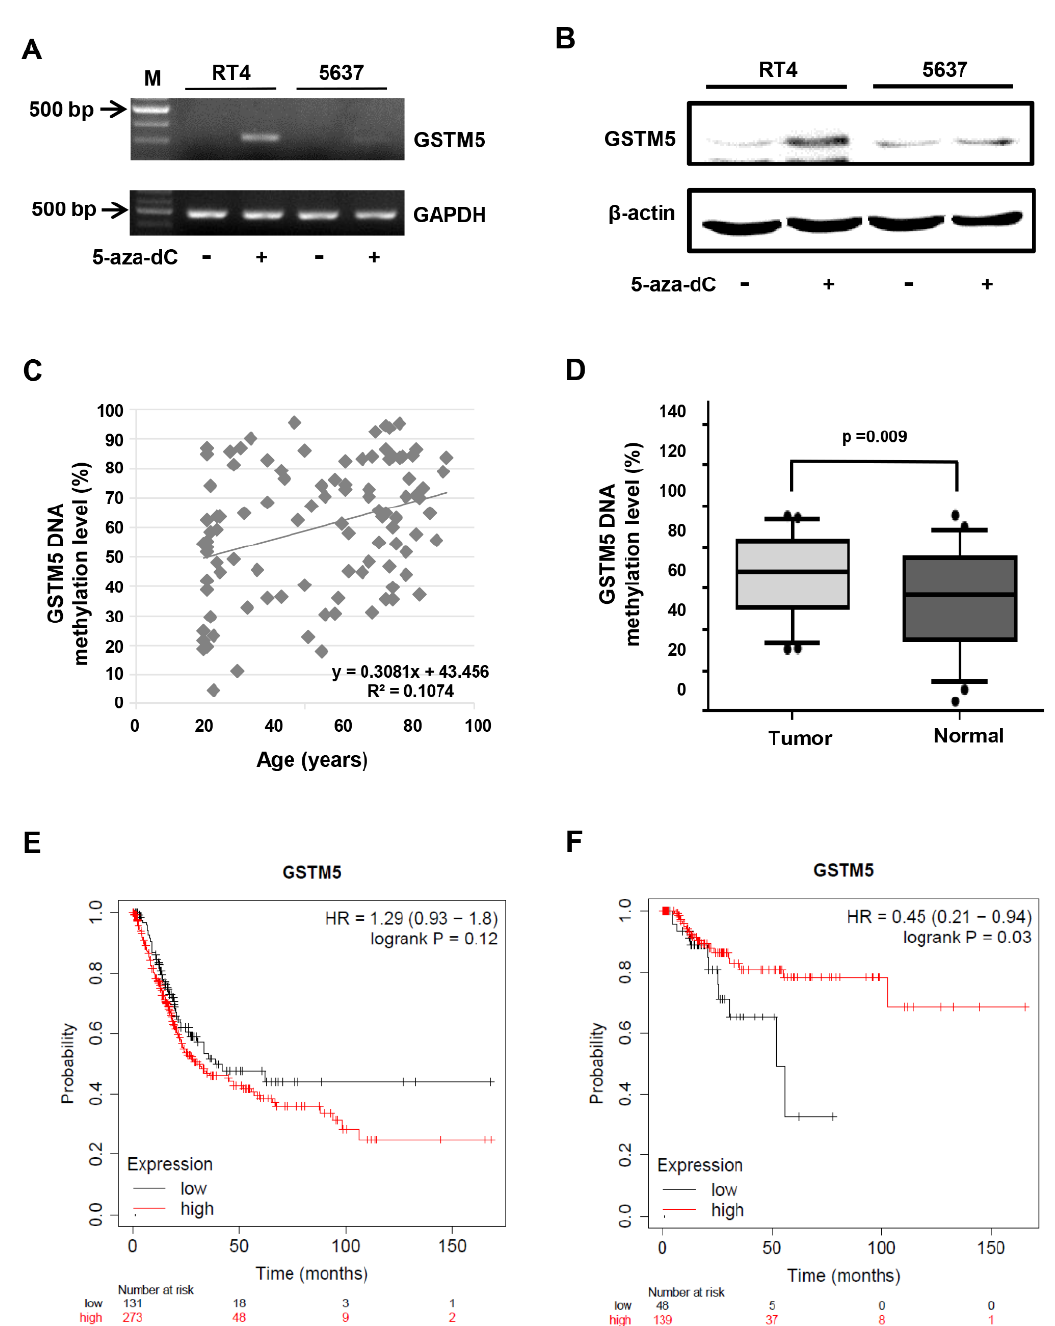
Figure 2. The status of GSTM5 DNA methylation in bladder cancer cells and clinical samples. ( A ) The effect of 10 µ M 5-aza-dC on GSTM5 mRNA expression. ( B ) The effect of 10 µ M 5-aza-dC on GSTM5 protein expression. The anti-GSTM5 antibodies were Abnova H00002949-D01P. ( C ) Correlation between age and GSTM5 DNA methylation level in 50 bladder cancer tissues and 50 normal human urine pellets. The linear regression formula is on the bottom right (R 2 = 0.1074), which was calculated by Microsoft Excel. ( D ) GSTM5 DNA methylation level in 50 bladder cancer tissues and 50 normal human urine pellets. The statistical results were analyzed by SigmaPlot. ( E ) Kaplan–Meier plot showing the overall survival probability of 404 bladder cancer patients. ( F ) Kaplan–Meier plot of the relapse-free survival probability of 187 bladder cancer